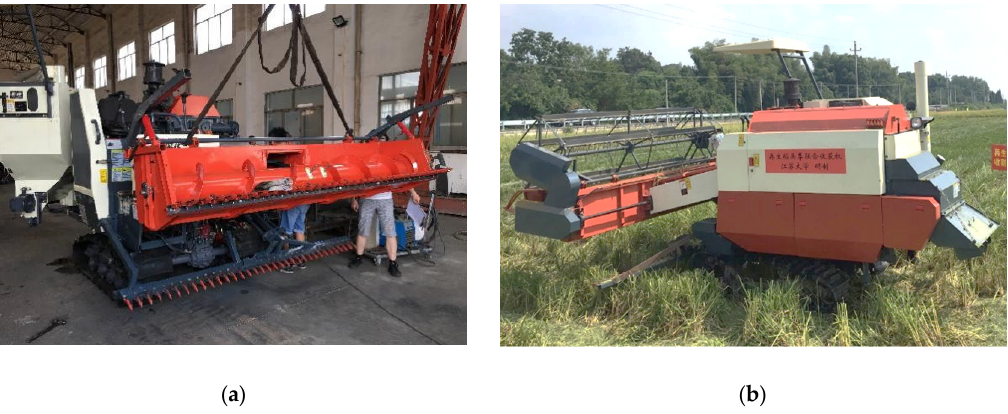
Figure 6. ( a ) Assembly and ( b ) field test of the double-cutterbar prototype. Table 1. The basic parameters of the developed harvester.